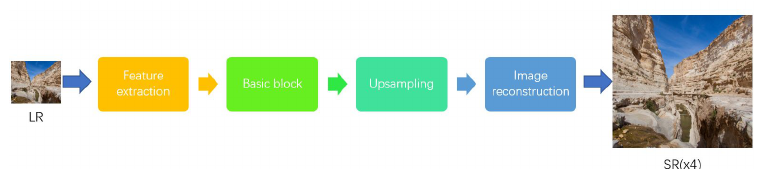
Figure 6. Super-resolution network framework (generator of GAN